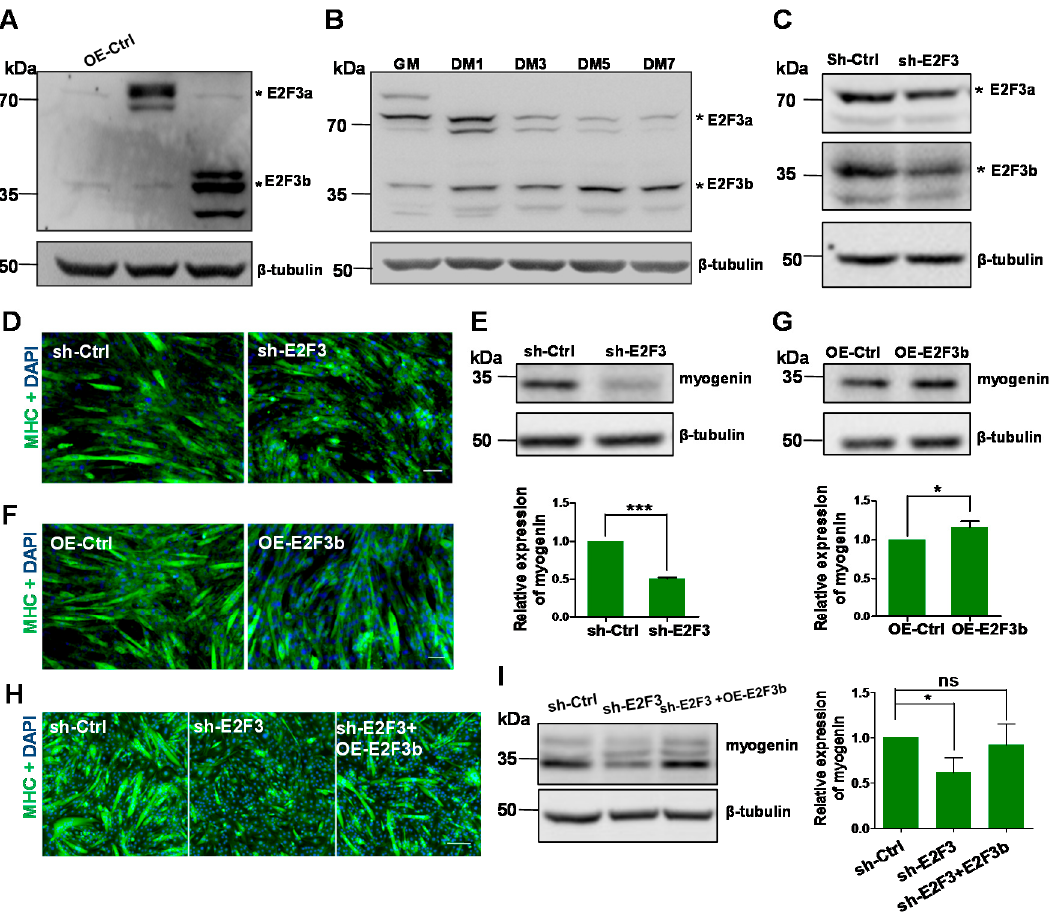
Figure 1. E2F3b is upregulated during myogenesis and is essential for myogenic differentiation. ( A ) Western blotting showing increased expression of E2F3a and E2F3b protein in C2C12 myoblasts transfected with vectors expressing E2F3a or E2F3b (OE-E2F3a, OE-E2F3b), compared with the control (empty vector, OE-Ctrl). β -tubulin was used as a loading control; ( B ) Western blotting showing the expression of E2F3a and E2F3b during myogenic differentiation. C2C12 cells were cultured in growth medium (GM) and switched to differentiation medium (DM) for one to seven days. β -tubulin was used as a loading control; ( C ) Western blotting confirmed the efficiency of sh-E2F3 on E2F3a and E2F3b protein expression in C2C12 cells. β -tubulin was used as a loading control; ( D ) Immunostaining of myosin showing that silenced E2F3b resulted in smaller myotubes. C2C12 cells were infected with sh-E2F3 vectors in DM for three days. Scale bar, 200 µ m; ( E ) Western blotting showing that silenced E2F3b resulted in a decreased myogenin level at DM3. β -tubulin was used as a loading control. Protein quantitation of myogenin was performed with Image J software. The error bars depict the mean ± SD of three cell samples; ( F ) Immunostaining of myosin showing that OE-E2F3b resulted in longer myotubes. C2C12 cells were lentivirally infected with vectors expressing OE-E2F3 in DM for three days. Scale bar, 200 µ m; ( G ) Western blotting showing that OE-E2F3b resulted in increased myogenin protein at DM3. β -tubulin was used as a loading control. Protein quantitation of myogenin was performed with Image J software. The error bars depict the mean ± SD of three cell samples; ( H ) Lentiviral E2F3b rescues the formation of myotubes in sh-E2F3 cells. sh-E2F3 cells were lentivirally infected by E2F3b, transferred to DM, and stained for Myosin heavy chain (MHC) and 4 ′ ,6-diamidino-2-phenylindole (DAPI) at DM4; ( I ) Western blotting shows that the introduction of E2F3b increases myogenin protein expression at DM4. Scale bar, 500 μ m. The error bars depict the means ± SD of three independent samples. * p < 0.05, *** p < 0.001 and ns, non-significant.